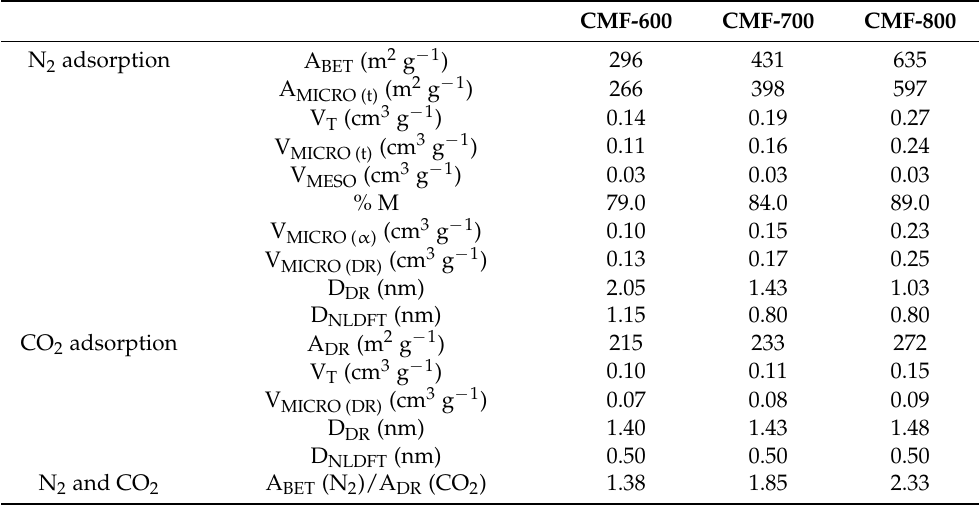
Table 2. Textural properties of CMFs by N 2 at − 196.15 ◦ C and CO 2 at 0 ◦